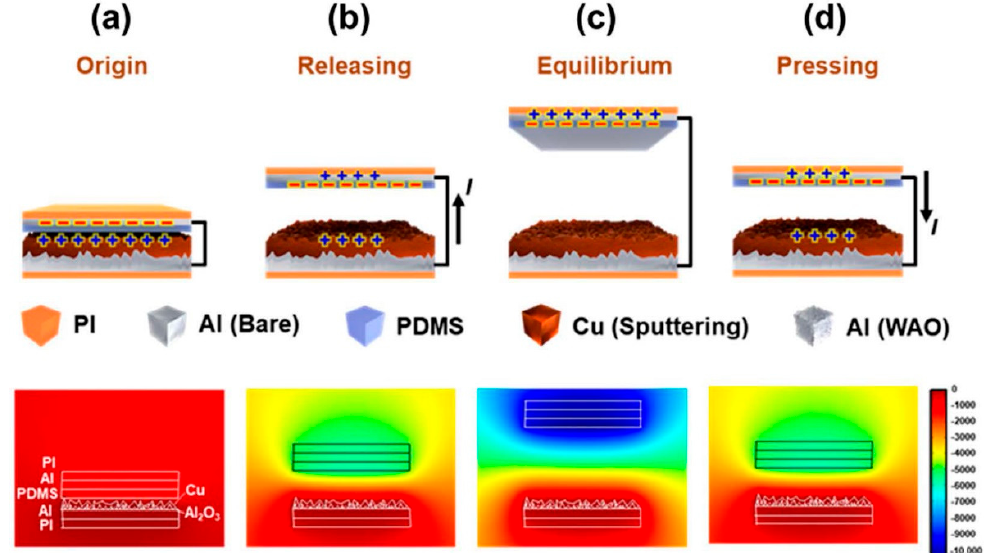
Figure 2. The working mechanism and potential difference from the COMSOL simulation results of the DE-TENG. ( a ) the origin state, ( b ) the releasing state, ( c ) the equilibrium state, and ( d ) the pressing state.